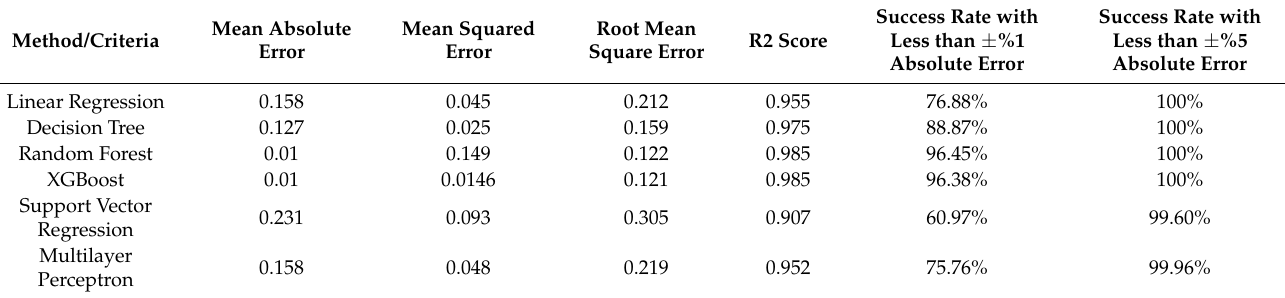
Table 1. Pressure prediction test performance